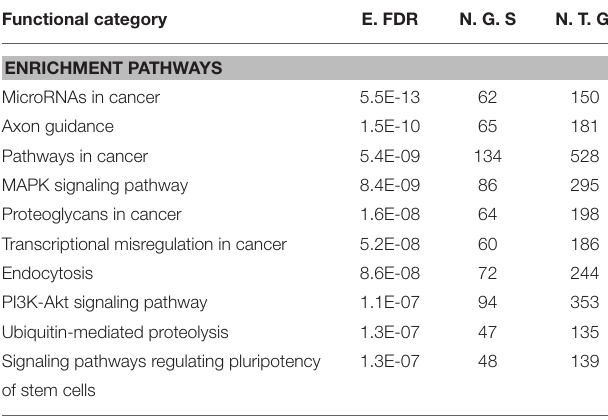
TABLE 3 | Pathway enrichment analysis of differentially expressed